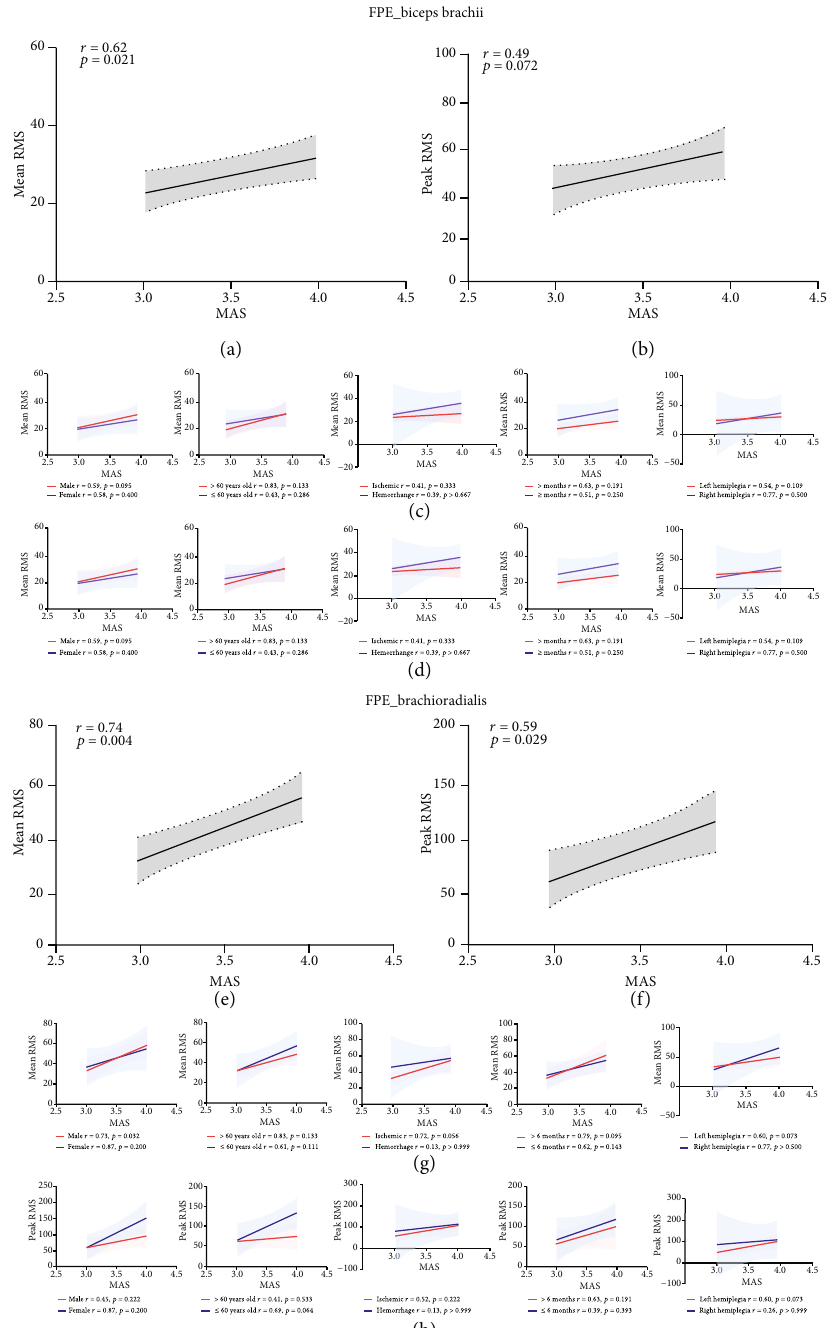
Figure 6: Correlation between sEMG values (mean and peak RMS values) and elbow fl exion (biceps brachii and brachioradialis) muscle tension during FPE on the paretic side. (a) Correlation between MAS score and mean RMS values of the biceps brachii during FPE. (b) Correlation between MAS score and peak RMS values of the biceps brachii during FPE. (c) Correlation between MAS score and mean RMS values of the biceps brachii during FPE in the subgroups (sex, age, stroke type, poststroke duration, and hemiparetic side (left/ right)). (d) Correlation between MAS score and peak RMS values of the a ff ected biceps brachii during FPE in the subgroups (sex, age, stroke type, poststroke duration, and hemiparetic side (left/right)). (e) Correlation between MAS score and mean RMS values of the brachioradialis during FPE. (f) Correlation between MAS score and peak RMS values of the brachioradialis during FPE. (g) Correlation between MAS score and mean RMS values of the brachioradialis during FPE in the subgroups (sex, age, stroke type, poststroke duration, and hemiparetic side (left/right)). (h)Correlation between MAS score and peak RMS values of the brachioradialis during FPE in the subgroups (sex, age, stroke type, poststroke duration, and hemiparetic side (left/right)). sEMG: electromyography; FPE: fast passive extension; MAS: modi fi ed Ashworth scale; RMS: root mean